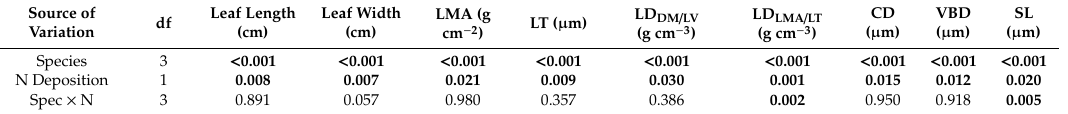
p -values in bold indicate significant effects.